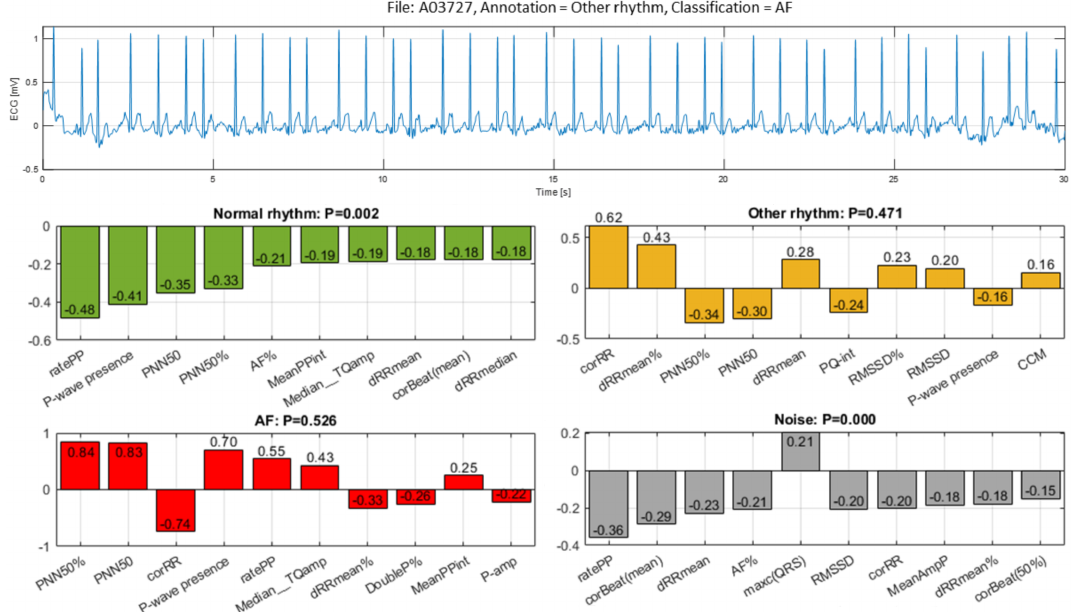
Figure 16. ECG example (file A03727) of erroneously classified Other rhythm as AF. The single-lead ECG strip is represen- tative to sinus rhythm with frequent supra-ventricular extrasystoles and varying RR intervals (due to post-extrasystole compensatory pause); and high-frequency artifacts of the isoelectric line, mimicking f-waves of AF. The barplots represent the Case Feature Importance of the top-10 ranked features, which maximally contributed to the output classification probability (P) in four rhythms. The ECG strip is detected as Other rhythm (P = 0.471) and AF (P = 0.526) with almost equal uncertainty by DenseNet-3@128-32-4 model based on HRV and atrial activity